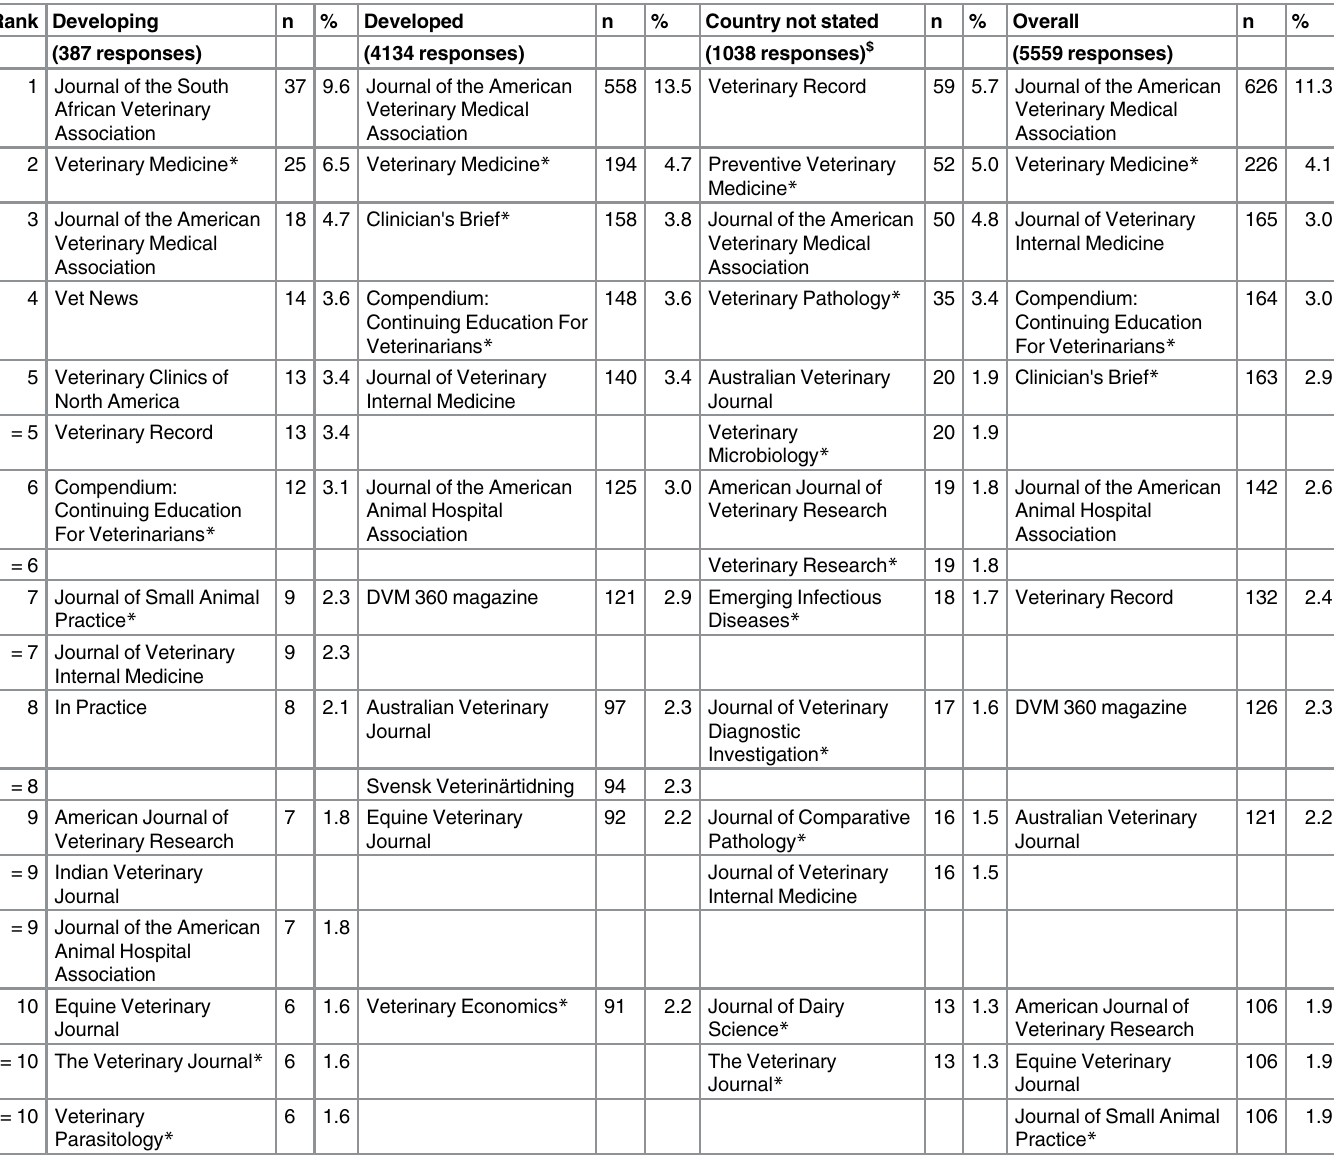
Table 4. Table of the top ten journals most read as nominated by respondents working in developing and developed countries. Respondents could nominate up to 10 different journals. Rank Developing n % Developed